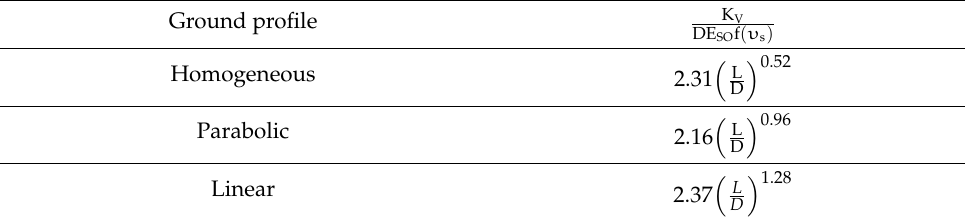
Table 2. Vertical stiffness for shallow skirted foundations exhibiting rigid